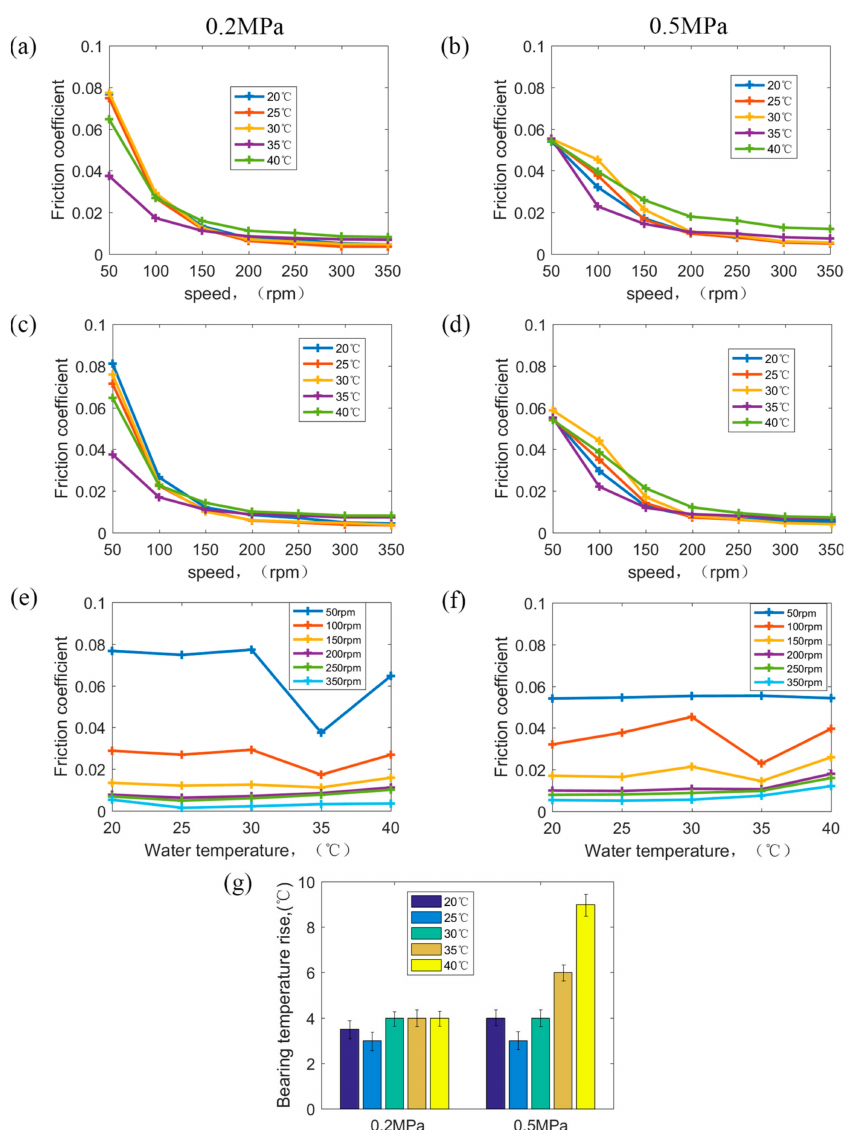
Figure 9. ( a ) COF vs. speeds at 0.2 MPa and ( b ) COF vs. speeds at 0.5 MPa with speeding down, ( c ) COF vs. speeds at 0.2 MPa and ( d ) COF vs. speeds at 0.5 MPa with speeding up. ( e ) COF vs. water temperature at 0.2 MPa, ( f ) COF vs. water temperature at 0.5 MPa. ( g ) Bearing temperature rise at different water temperatures under 0.2 MPa and 0.5